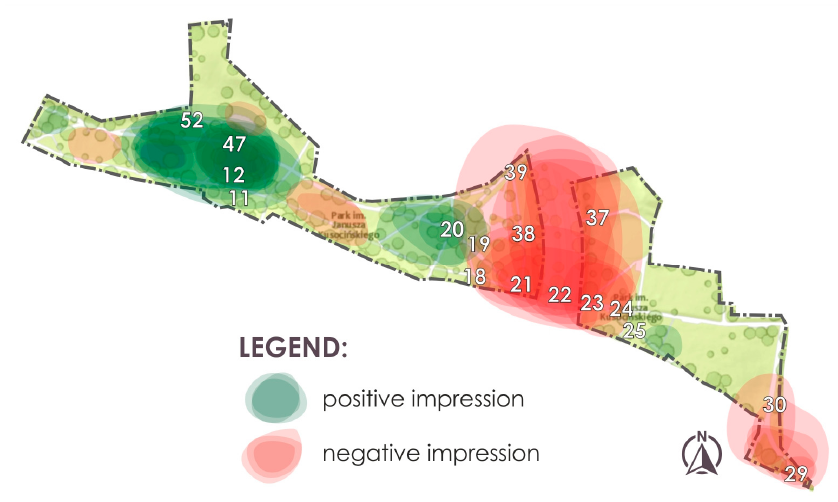
Figure 11. Mental map of the Kusoci ń skiego Park. Respondents identified noisy spaces (red) and noise-free and positive-sounding spaces (green).